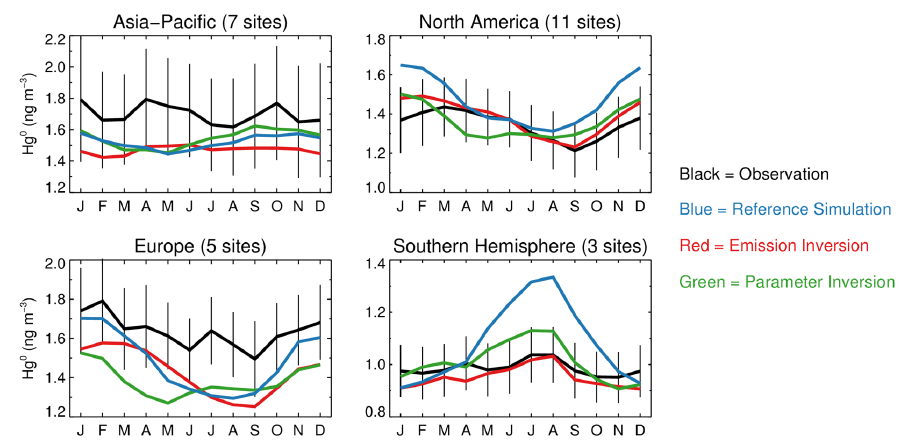
Figure 4. Averaged monthly observations and model simulations of Hg 0 concentrations for the ground-based observational sites in the four regions (Asia-Pacific: 45 ◦ E–140 ◦ W, 0–90 ◦ N; North America: 140–45 ◦ W, 15–90 ◦ N; Europe: 15 ◦ W–45 ◦ E, 15–90 ◦ N, and the Southern Hemisphere). Note different scales on vertical axes. Hg 0 observations are shown with total errors as described in Sect.